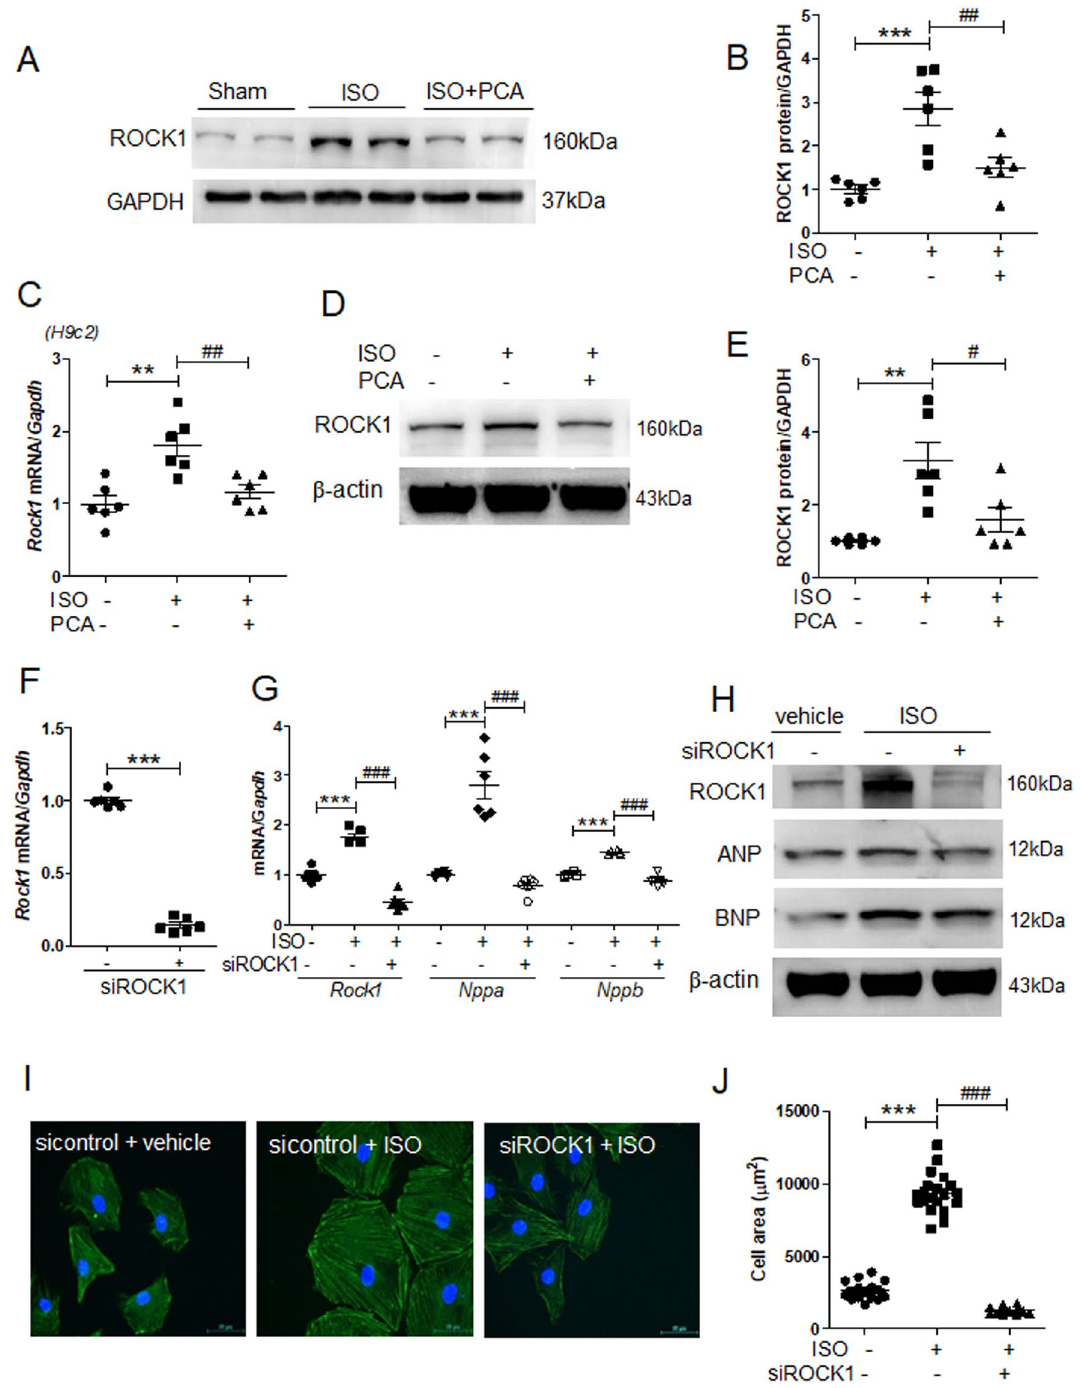
Figure 3. ROCK1 knockdown reduces isoproterenol-induced cardiomyocyte hypertrophy. ( A ) Heart tissues from sham, isoproterenol, and isoproterenol + protocatechuic acid treated mice were analyzed by western blotting using anti-ROCK1 and GAPDH antibodies. Representative images. ( B ) Quantification of ROCK1 protein levels in heart tissues (n = 6); the results were normalized to GAPDH. ***P < 0.001; ## P < 0.01. ( C − E ) H9c2 cells were serum starved overnight and then treated with isoproterenol (10 μM) in the presence or absence of protocatechuic acid (10 μM) for 6 h. ( C ) mRNA levels of Rock1 (n = 6) . **P < 0.01; ## P < 0.01. ( D ) Western blot analysis. Representative images of ROCK1. ( E ) Quantification of western blots presented in ( D, n = 6). **P < 0.01; # P < 0.05 . ( F ) H9c2 cells were transfected with either control or ROCK1 siRNA for 2 days. The mRNA levels of Rock1 were analyzed using RT-PCR. ***P < 0.001, Student’s t -test. ( G ) RT-PCR analysis of Rock1, Nppa , and Nppb expression in H9c2 cells transfected with either control or ROCK1 siRNA in the presence or absence of isoproterenol (10 μM, n = 6). ***P < 0.001; ### P < 0.001. ( H ) Western blot analysis of cells described in ( G ). Representative images of ROCK1, ANP, and BNP; β-actin was used as a loading control. ( I ) Representative merged images of H9c2 cells transfected with either control or ROCK1 siRNA, incubated with 10 μM isoproterenol for 24 h, and then stained. F-actin filaments (green) and DAPI (blue). Scale bar = 50 μm. ( J ) Cell area quantification of H9c2 cells cultured on 12-well plates (n = 20 cells). ***P < 0.001; ### P < 0.001. ISO, isoproterenol; PCA, protocatechuic acid. Data are presented as the mean ± S.E. Statistical analysis: one-way ANOVA followed by Bonferroni post hoc tests. Graphs were prepared using GraphPad